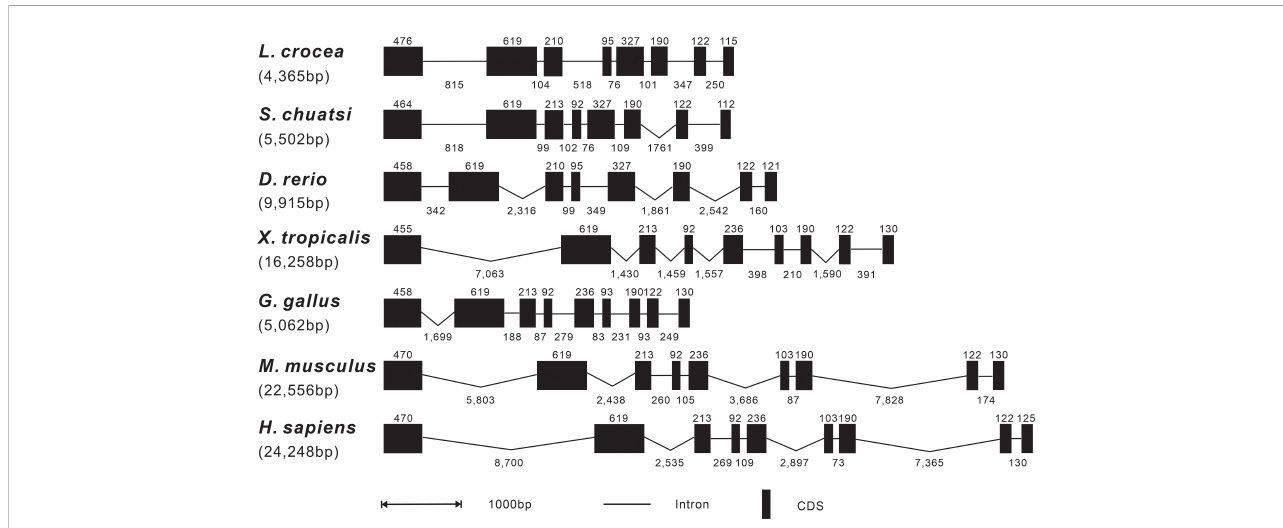
FIGURE 2 Genomic organization comparison of Lc-SARM with other vertebrates. Comparison of the genomic organization of SARM gene in S. chuatsi , D. rerio , X. tropicalis , G. gallus , M. musculus , and H. sapiens . Exons are represented by black boxes, with the lengths in base pairs (bp) shown above the black boxes. Introns are represented by black lines, and the lengths in bp are shown below the lines. Gene sequence information and the GenBank accession numbers are presented as follows: L. crocea , NC_040017.1 (14896355-14890040); S. chuatsi , NC_058048.1 (16261494-16255179); D. rerio ,